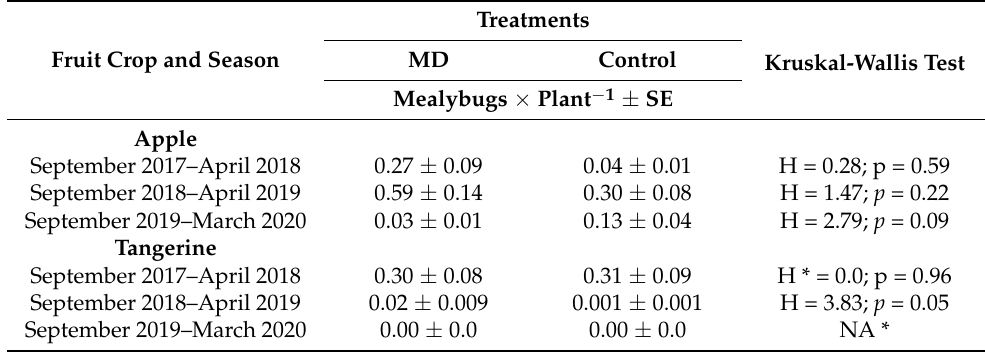
Table 1. Mean number of mealybugs (all life stages) per plant over the season for the three seasons studies, in mating disruption (MD) and control plots in tangerine and apple orchards. Twelve plants per experimental unit were monitored (60 plants per treatment in each